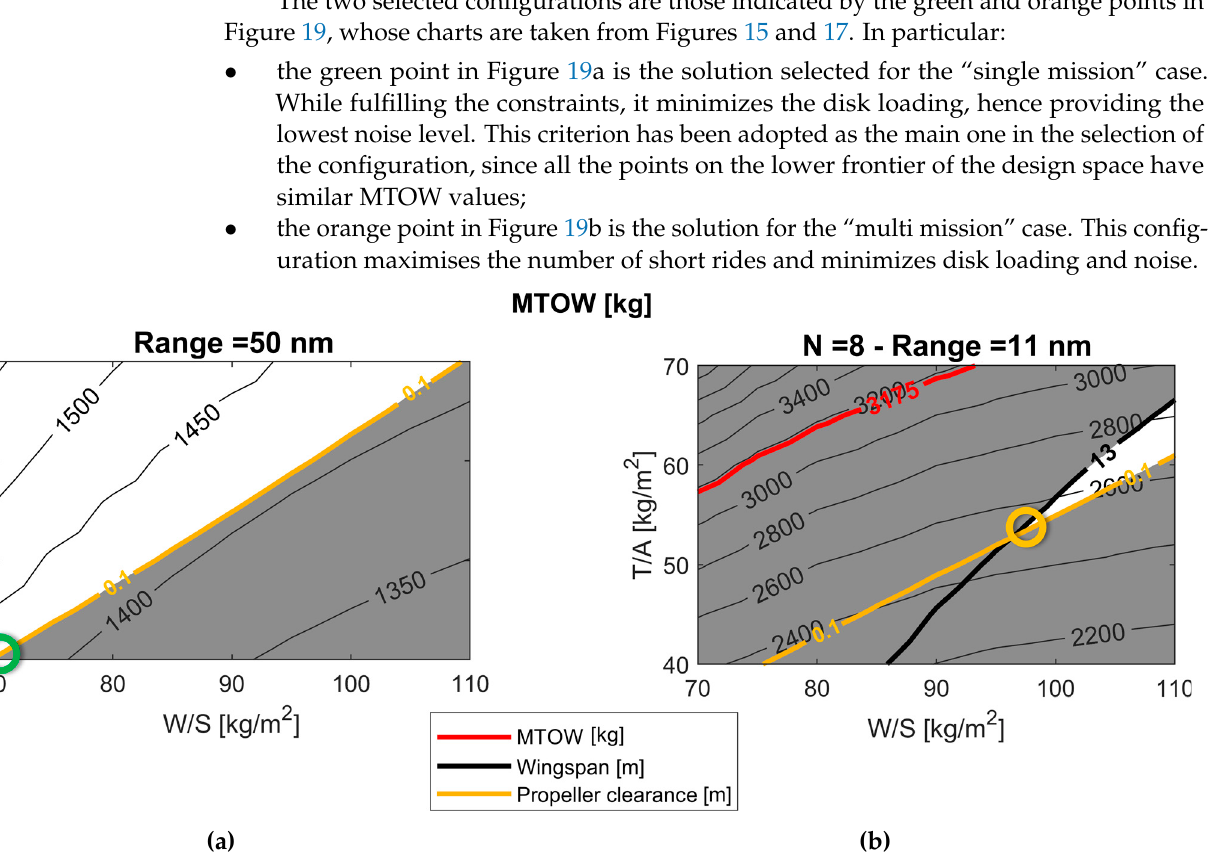
( b ) Figure 20. Details of the TiltOne configuration for single mission case: ( a ) top view; ( b ) mass breakdown. Table 14. Main performance data of the TiltOne configuration for single mission case. Single Mission N. of passengers